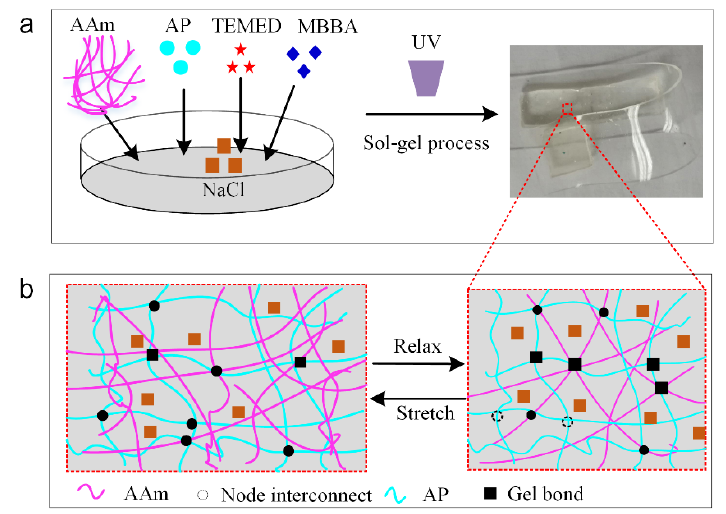
Figure 2. Fabrication process of RES. ( a ) Sol–gel process for conductive ionic gel fabrication. ( b ) Schematic graph of the stretching and relaxing process of the conductive ionic hydrogel.